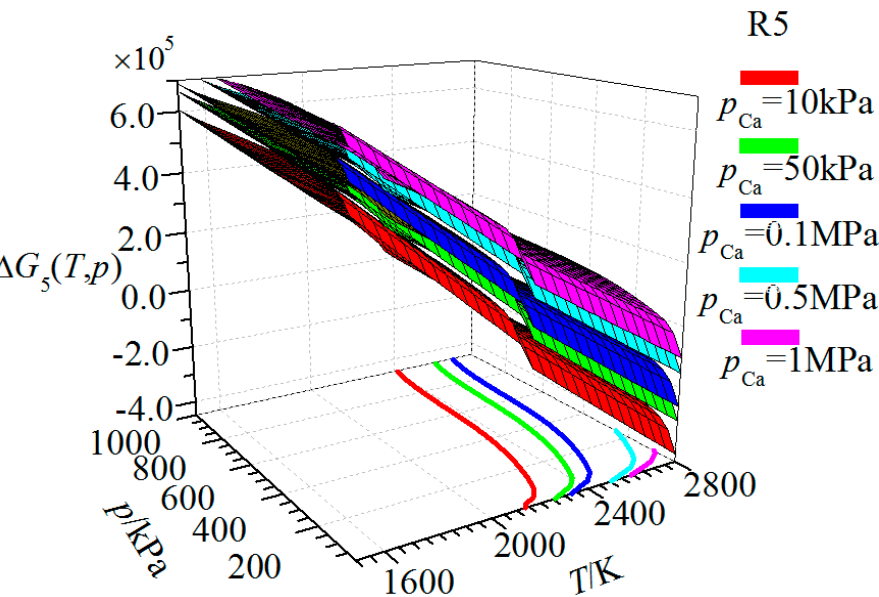
Figure 10. Gibbs energy dependence on temperature and Ca and CO partial pressure for reaction